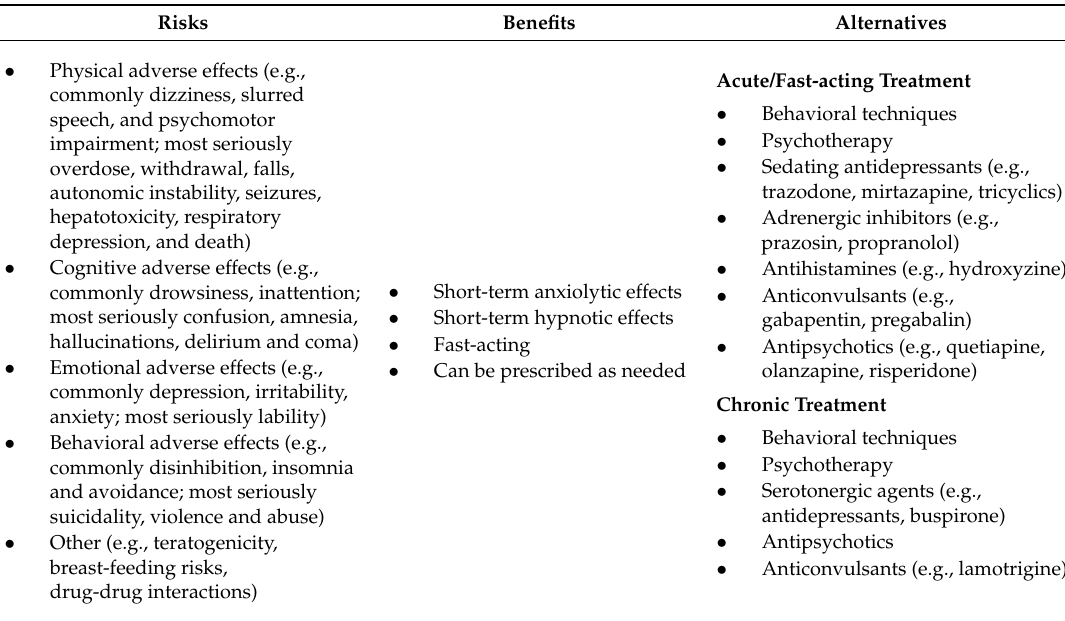
Table 1. Benzodiazepine risks, benefits, and